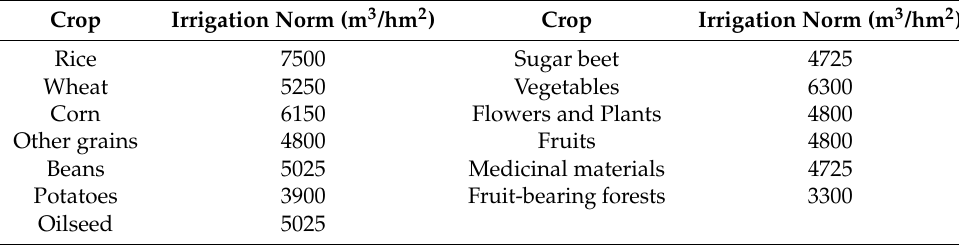
Table 2. Irrigation norm for crop growth in the Hexi area of Gansu province.